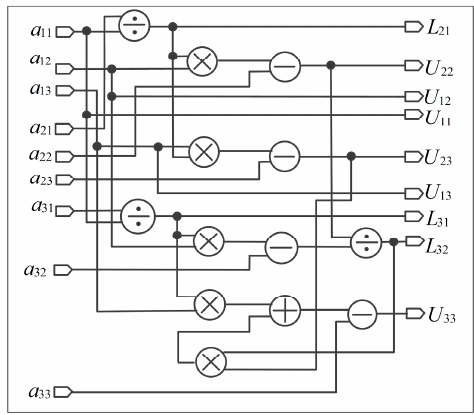
Figure 7. Parallel computation block lower-upper (LU) decomposition of A 11 .